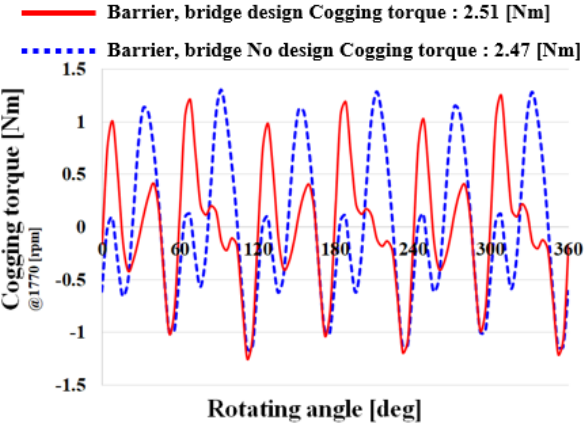
Figure 15. Cogging torque waveform before and after barrier and bridge design was applied.